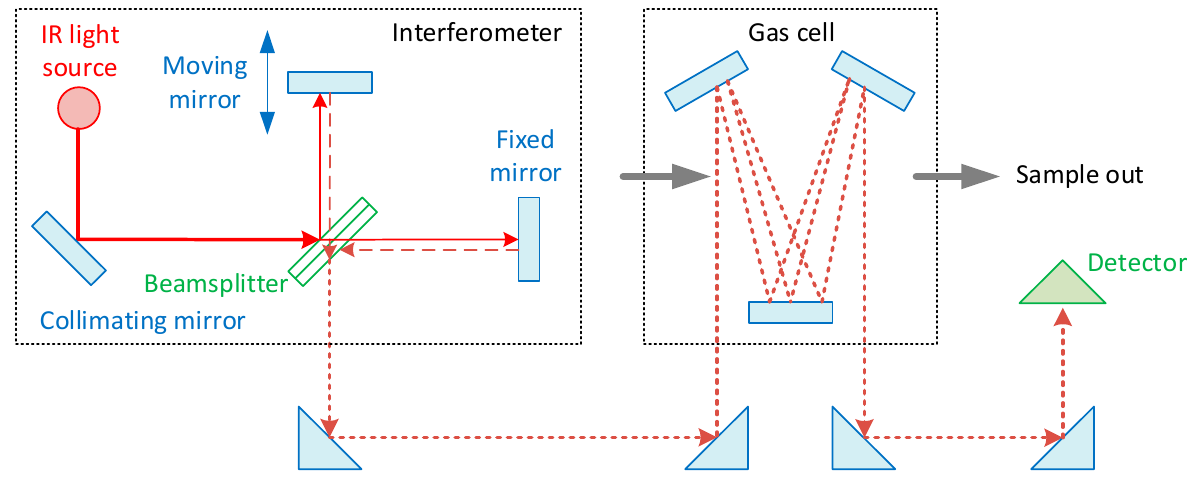
Figure 1. Principle of operation of FTIR (Fourier transform infrared) spectroscopy. IR = infrared.